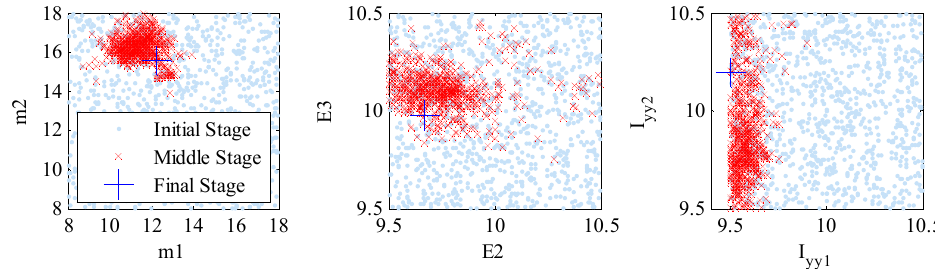
Figure 9. Plot of samples in the structural model parameter space generated at the initial, middle and final stages of TMCMC for model class M 2 . Table 5. Posterior Mean, C.O.V., and percentage change in structural model parameters.